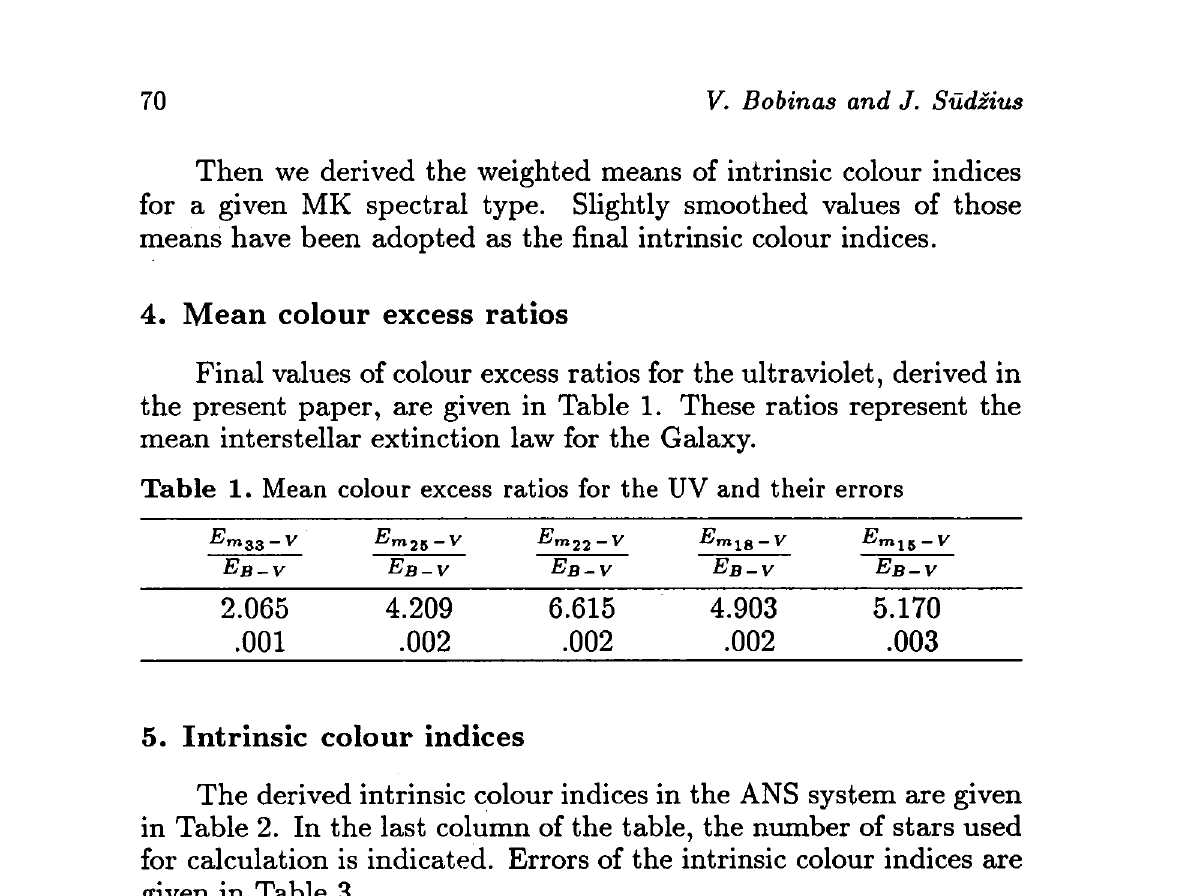
Table 2. UV intrinsic colour indices, (m\-V) o, for O-B